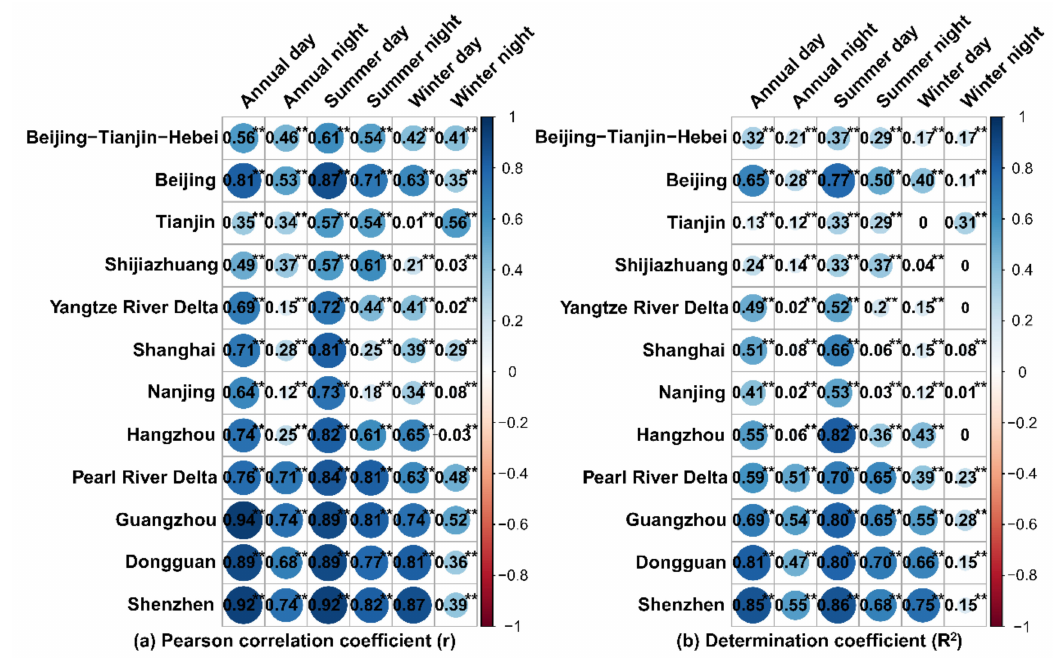
Figure 7. Correlations between impervious surface density and land surface temperature during daytime and nighttime of annual, summer and winter seasons across di ff erent cities and urban agglomerations. ( a ) Pearson correlations coe ffi cient (r); ( b ) determination coe ffi cient (R 2 ). Blue means positive correlation, red means negative correlation, the larger circle indicates the stronger coe ffi cient. At significance level of 0.01 denoted as